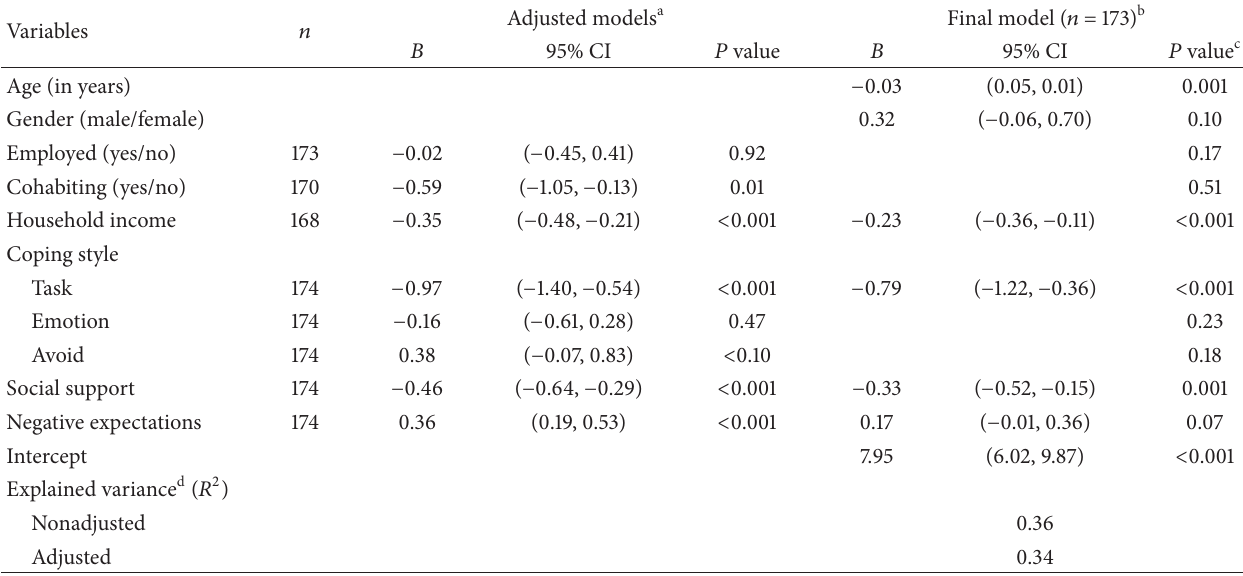
Table 3: Multiple linear regression of coping styles and other predictive factors on emotional status (anxiety and depression complaints) measured at long-term followup (24 months) at Krokeide Rehabilitation Centre, Bergen, Norway, included from